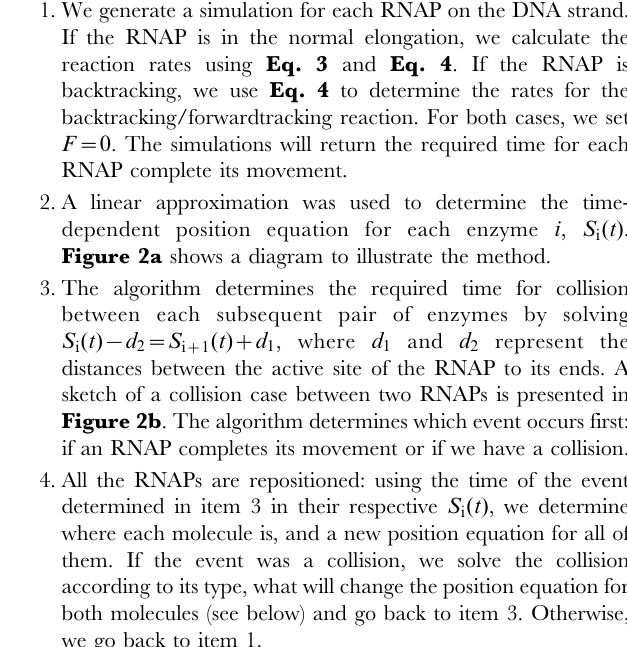
The first term is the free energy due to the break of the hydrogen bonds between complementary nucleotides on the double-strand DNA and the second term is the free energy due to the formation of the RNA-DNA hybrid duplex. They are clearly sequence-dependent and we use the nearest-neighbor model for both [17]. We used SantaLucia et al. [18] values for the DNA-DNA energy and Sugimoto et al. [19] values for the RNA- DNA hybrid energy. The third term represents the interactions between the RNAP and the nucleic acids, considered sequence- independent and, for simplification, as zero. For further details and considerations on these calculation, see Bai et al. [4].